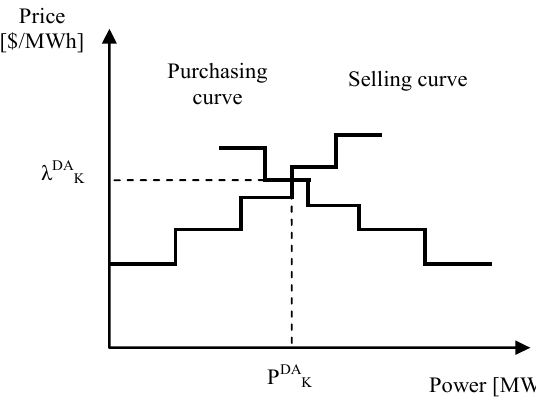
Figure 1. The principle of clearing price in DA